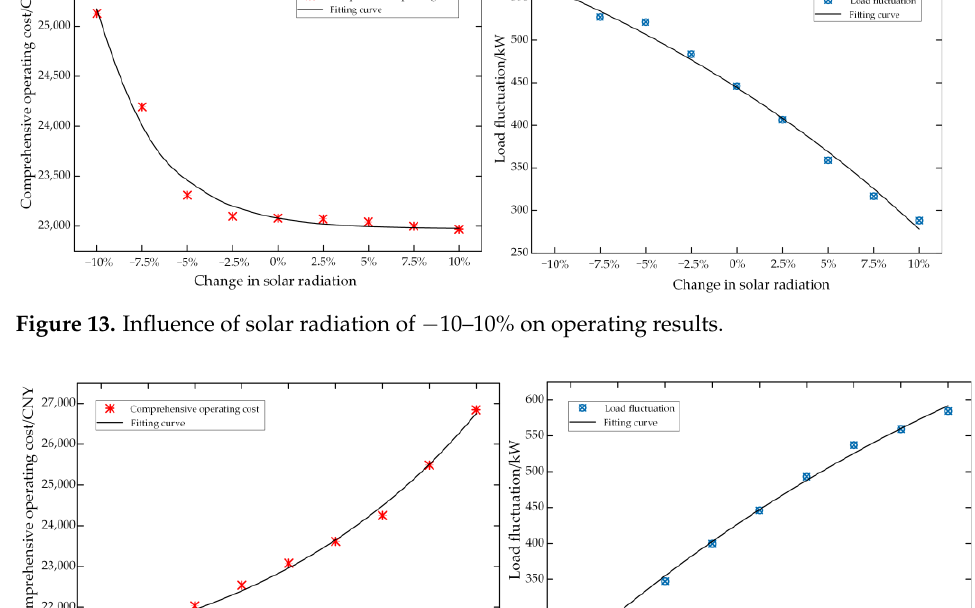
24 of 27 Figure 12. Influence of different elastic coefficients on operating results. In Figure 12, three elastic coefficients are given, which are reduced once and twice compared to the original elastic coefficient  =−=−